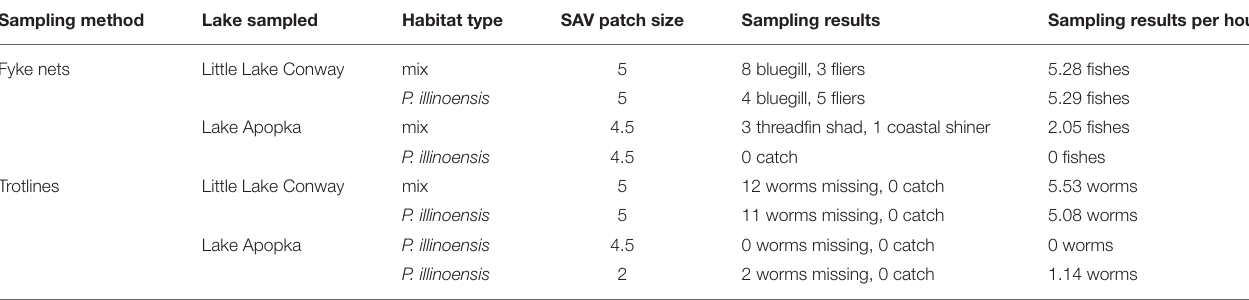
TABLE 1 | Results of method validation testing in Lake Apopka and a macrophyte-dominated lake, Little Lake Conway. Sampling method